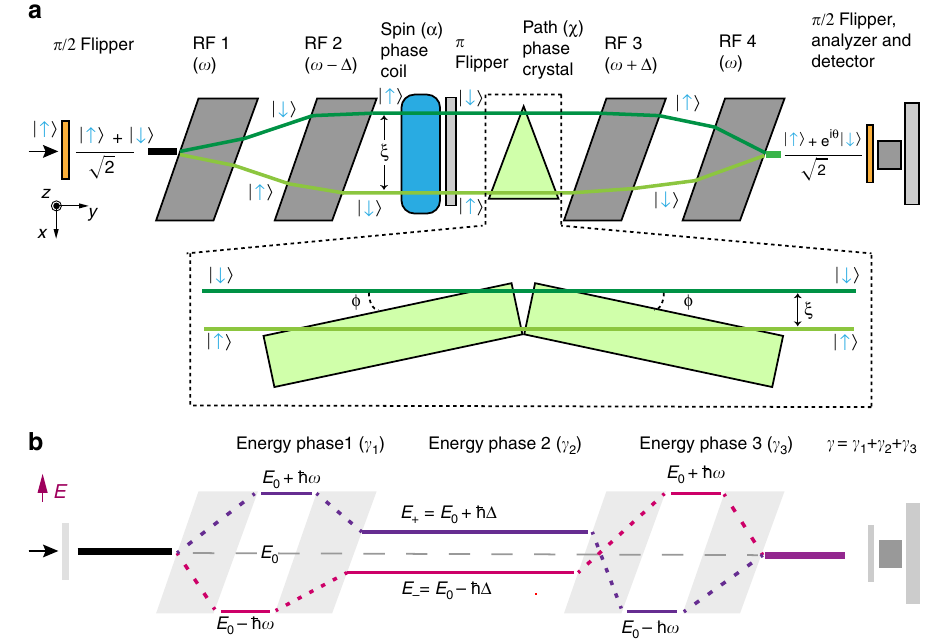
Fig. 1 Sketch of the paths and energies of neutron spin states in the interferometer. a Schematic plan view of the main spin manipulation components of the Larmor instrument showing the evolution of the neutron path and spin states along the beam line with neutrons propagating from left to right in the y direction. A small z-directed fi eld is applied between the fi rst π /2 fl ipper and the π fl ipper in the middle of the instrument. After the π fl ipper, the applied fi eld is reversed. A superposition of up and down spin states, produced by a π /2 fl ipper at the beginning of the instrument passes through two RF fl ippers (RF1 and RF2) whose static magnetic fi elds cause the up and down states to be refracted along different paths that are separated by the entanglement length, ξ , in the space between the second and third RF fl ippers. In the absence of the spin-phase coil (blue) and path-phase crystal (green), the two states are disentangled by the second pair of RF fl ippers (RF3 and RF4) to yield a spin echo whose polarization is measured using a π /2 fl ipper, a polarization analyzer and a neutron detector. The phase change, θ , is de fi ned as the sum of the subsystems phases. A small additional z-directed magnetic fi eld (blue) is used to alter the relative phases of the two spin states. Two rectangular quartz crystals, shown in more detail within the dashed-line box, cause the two neutron paths to accumulate different phases as the paths travel different distances in air and in quartz. b A plot of the total neutron energy for each neutron spin state along the beam line. Each RF fl ipper reverses a neutron spin state at the same time as it exchanges a quantum of RF energy with that state. A difference in the energy phase between the two spin states develops in the space between each pair of RF fl ippers because the two states have different total energies. In the normal spin-echo condition, Δ = 0 and the energy phase developed between the fi rst two RF fl ippers ( γ 1 ) is canceled by that developed between the second pair of RF fl ippers ( γ 3 ). When Δ ≠ 0 the total energy phase ( γ ) is to 3 π /2 radians for 0.4-nm-wavelength neutrons. After the spin and path phases have been set, the neutron spin is reversed by a π fl ipper before traveling through the third and fourth RF fl ippers which disentangle the states. A fi nal π /2 fl ipper projects the neutron spin onto the x axis where the neutron intensity is measured using a supermirror spin analyzer and a set of 3 He tube detectors.